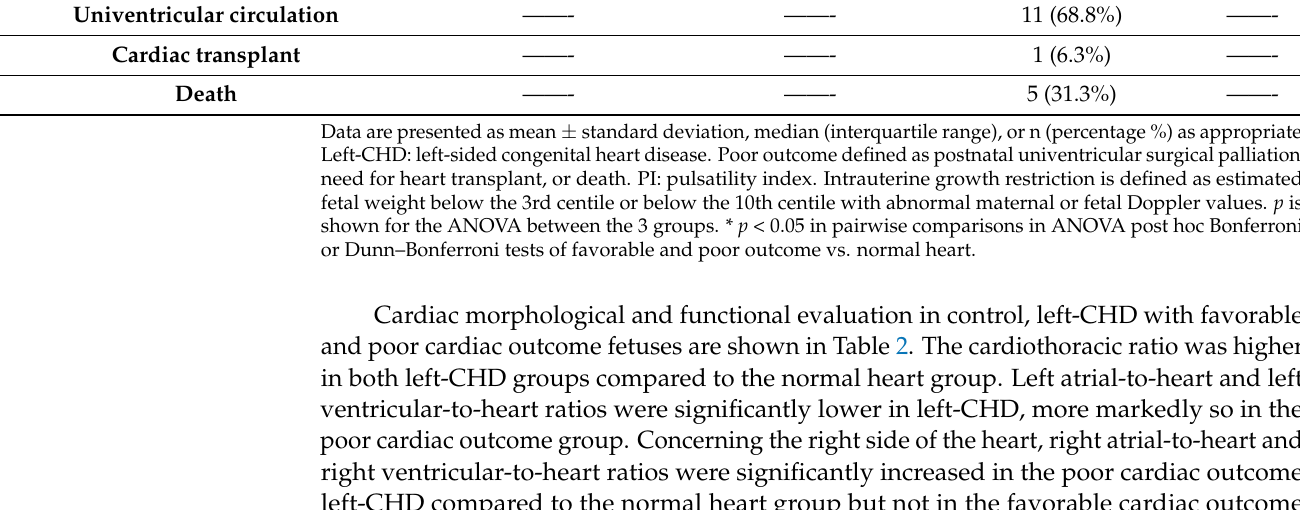
Cardiac morphological and functional evaluation in control, left-CHD with favorable and poor cardiac outcome fetuses are shown in Table 2. The cardiothoracic ratio was higher in both left-CHD groups compared to the normal heart group. Left atrial-to-heart and left ventricular-to-heart ratios were significantly lower in left-CHD, more markedly so in the poor cardiac outcome group. Concerning the right side of the heart, right atrial-to-heart and right ventricular-to-heart ratios were significantly increased in the poor cardiac outcome left-CHD compared to the normal heart group but not in the favorable cardiac